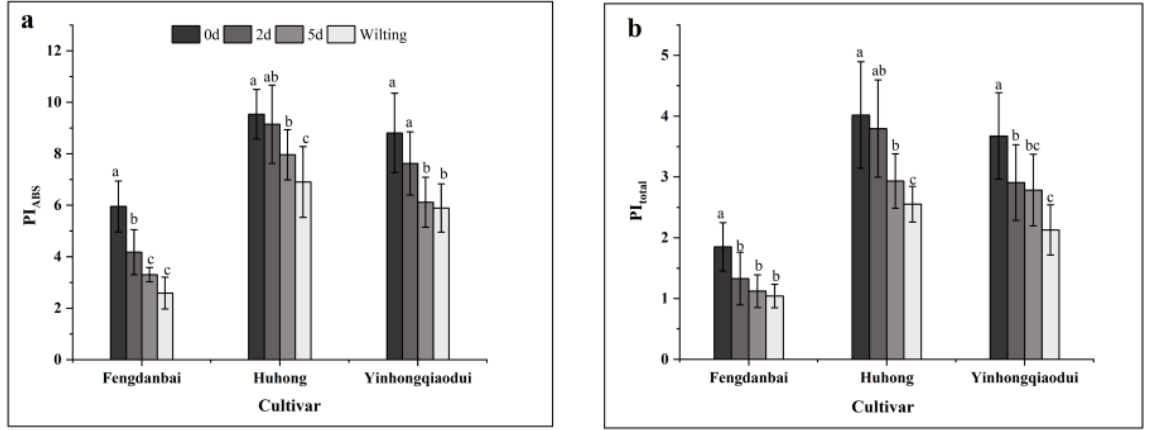
Figure 6. Effects of high-temperature stress on PS II performance index for PI ABS and PI total values of ‘Fengdanbai’ ‘Yinhongqiaodui’ and ‘Huhong’ cultivars of peony leaves. Performance index showing absorption basis (PI ABS ; ( a )) and performance index (potential) for energy conservation from exciton to the reduction of PS I end acceptors (PI total ; ( b )). Different lowercase letters indicate significant differences at the p < 0.05 level for different stress times for the same species. Correlation analysis was conducted on 14 kinetic parameters of chlorophyll fluores- cence for peony leaves under high-temperature stress, and the results are shown in Table 6. Among the above indicators, Fv/Fm was significantly positively correlated with Fv, Fv/Fo, and RC/CS m ; significantly positively correlated with PI ABS ; and significantly negatively correlated with ABS/RC, TRo/RC, and DIo/RC. PI ABS , a comprehensive index of the changes in the reaction optical system, is positively correlated with Fv/Fm, Fv/Fo, Ψ o , ϕ Eo , and PI total and negatively correlated with Fo, Mo, and V j . The cross correlation between the other indicators is